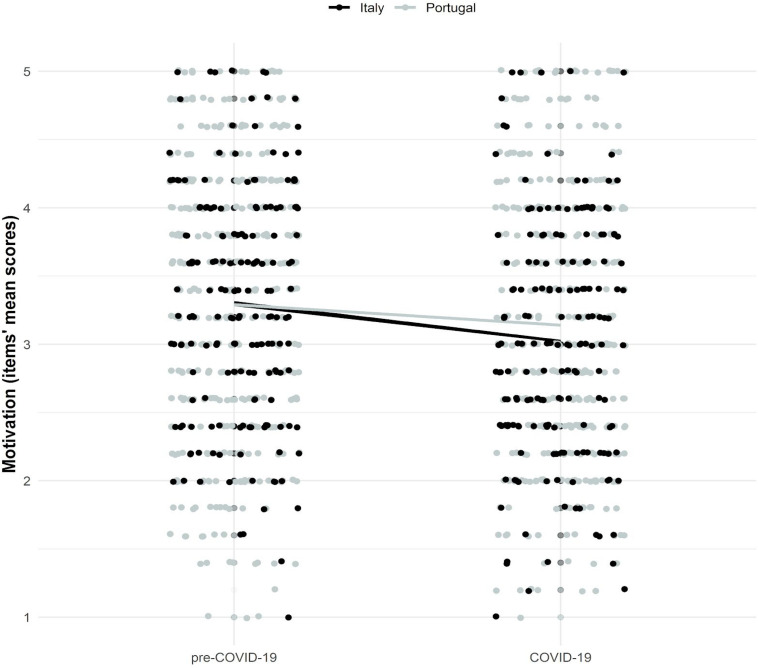
Motivation changes across time and samples. Pre-COVID-19 motivation items’ mean scores (MItaly = 3.31, MPortugal = 3.29) are similar to the pre-COVID-19 mean latent motivation score estimated by the LCSM (3.10). COVID-19 motivation items’ mean decrease (Italy = −0.29, Portugal = −0.15) is similar to the mean latent change score estimated by the LCSM (Italy = −0.27, Portugal = −0.14; p < 0.001). Figure drawn using ggplot2 package (3.2.1; Wickham, 2016) in R.